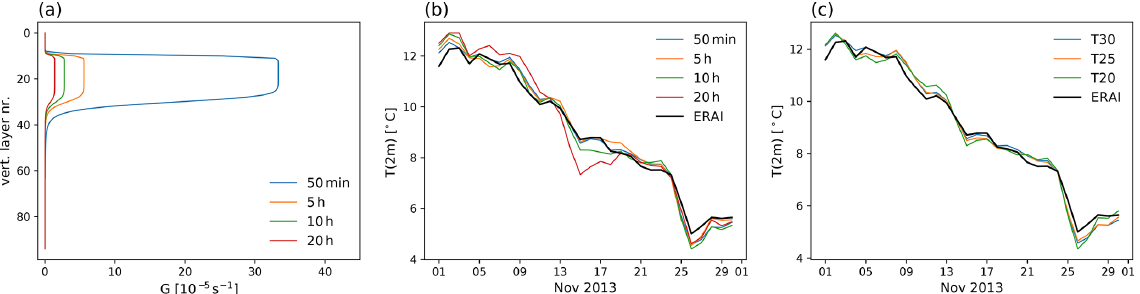
Figure 1. (a) Nudging strength G [10 − 5 s − 1 ] as a function of model level for different choices of minimum e-folding time as indicated. (b) Daily mean temperatures at 2m height [ ◦ C] of ECHAM6 in November 2013 averaged over the European domain (35–60 ◦ N, 10 ◦ W– 35 ◦ E) using the different e-folding times shown in (a) in comparison to ERA-Interim. (c) Daily mean temperatures as in (b) but with a 50min nudging timescale at different truncations again in comparison to ERA-Interim.